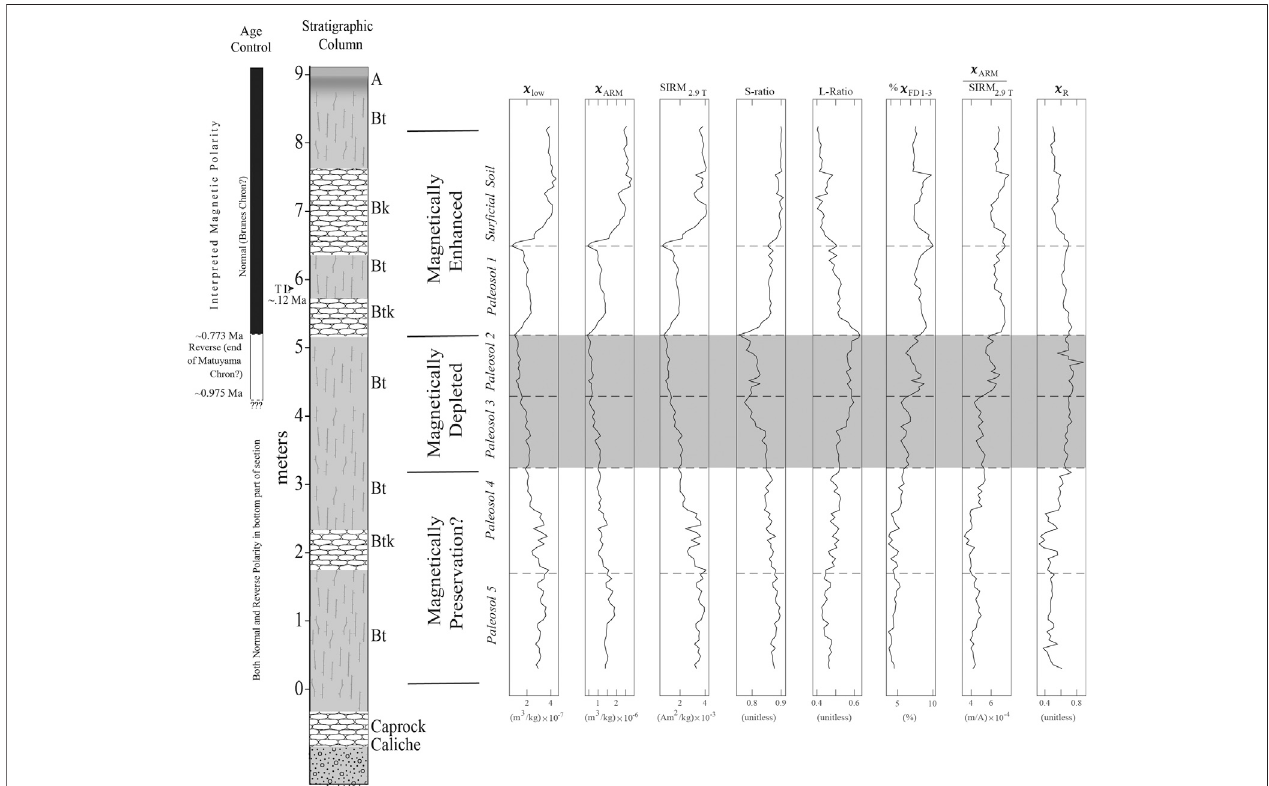
FIGURE 3 | Principal rock-magnetic parameters ( χ low , χ ARM , and SIRM 2.9T ) in addition to Environmental-magnetic ratios (S-ratio, L-ratio, % χ FD1-3 , χ ARM /SIRM 2.9T , and χ R ) all plotted as a function of depth in the type section. Note the similarity in behavior among all of the principal rock-magnetic parameters. The various rock- magnetic experiments in this paper show that the principal rock-magnetic parameters are primarily a re fl ection of the concentration of low-coercivity ferrimagnetic phases (magnetite and maghemite) (Thompson and Old fi eld, 1986; Evans and Heller, 2003; Jordanova, 2016). This is supported by the high and low values of the S-ratio(Stineetal.,2020)andL-ratio(thisstudy),respectively(Liuetal.,2007b).Low% χ FD1-3 , χ ARM /SIRM 2.9T ,and χ R valuesforPaleosols5and4implythatthemagnetic signal is controlled primarily by a wide distribution of coarse magnetic phases, which were likely detrital in origin (Thompson and Old fi eld, 1986; Evans and Heller, 2003; Hrouda, 2011; Jordanova, 2016; Stine et al., 2020). By contrast the relatively high % χ FD1-3 , χ ARM /SIRM 2.9T , and χ R values for Paleosols 3- Sur fi cial Soil implies that the magnetic signal is controlled by fi ne, potentially SP-SD magnetic phases (Hrouda, 2011; Maxbauer et al., 2016a), and thus the magnetically enhanced and depleted signals are likely a re fl ection of environmental